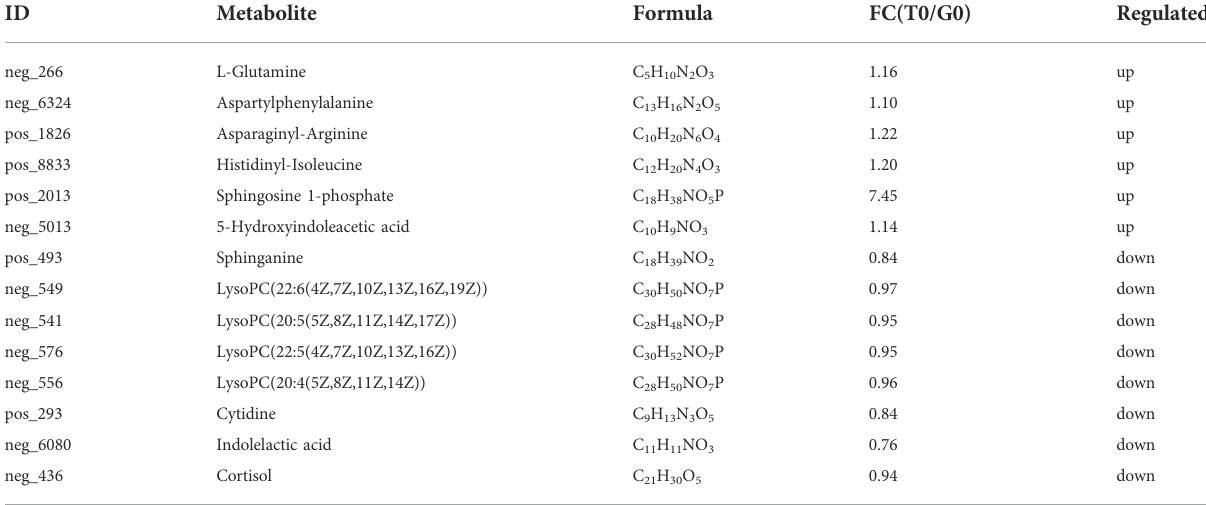
TABLE 6 Major different metabolites of T0 group vs. G0